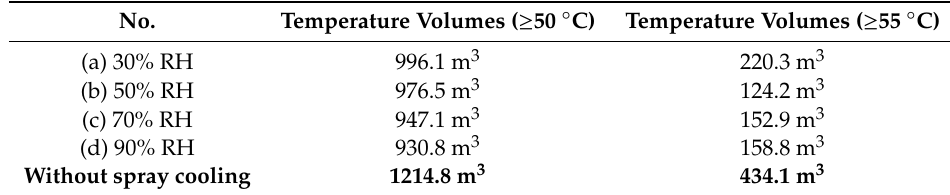
Table 6. Isothermal areas of the high-temperature